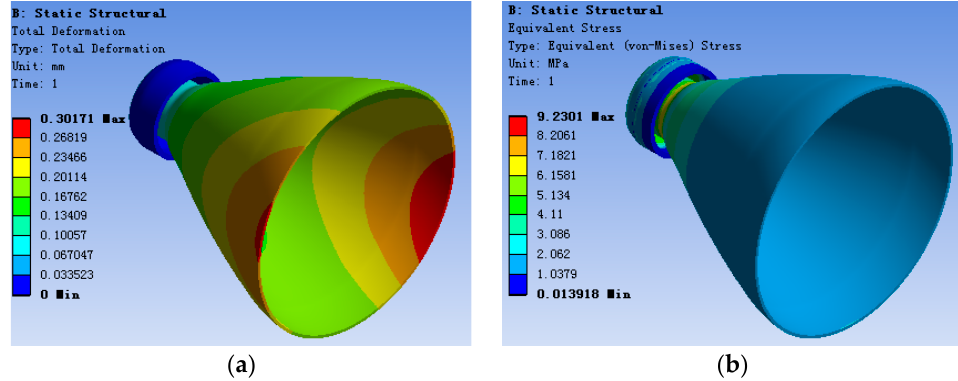
Figure 22. Cloud map of ground nozzle properties. (High altitude, 6 MPa.) ( a ) Structure Deformation. ( b ) Stress Distribution.